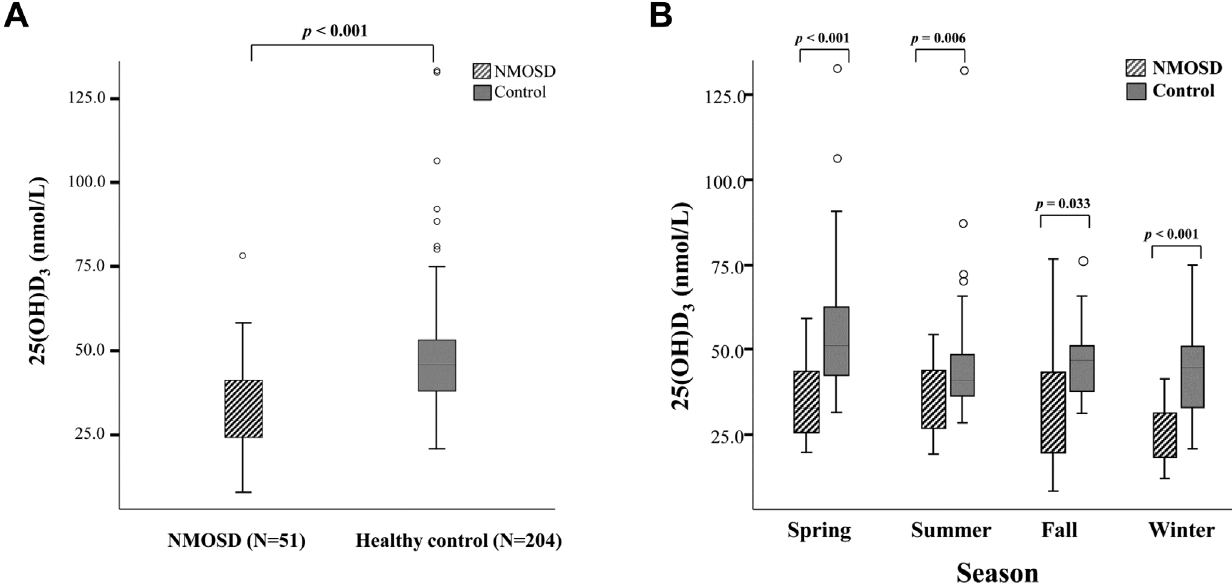
Figure 1. Vitamin D levels in patients with neuromyelitis optica spectrum disorder (NMOSD) ( n =51) and healthy controls ( n =204). A. Patients with NMOSD showed significantly lower 25(OH)D 3 levels, compared to healthy controls. B. Vitamin D levels sampled in the spring, summer, fall and winter were all significantly lower in patients with NMOSD than those in healthy controls. doi:10.1371/journal.pone.0107274.g001 PLOS ONE |